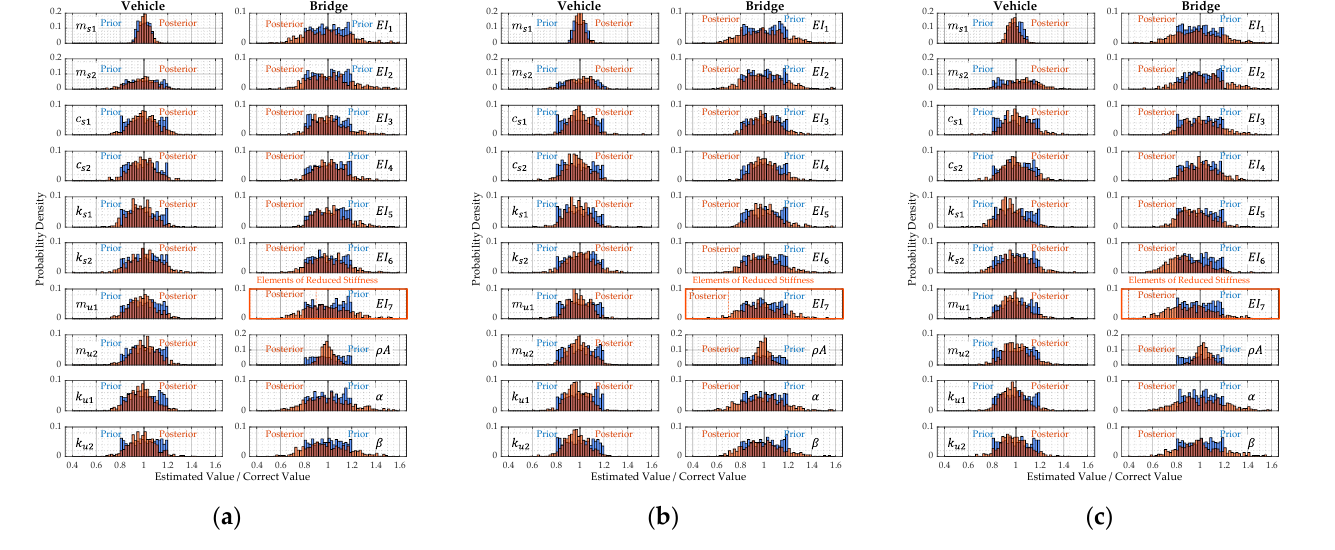
Figure 16. The application results of the PRE method: ( a ) Scenario 10 (stiffness decrease section: